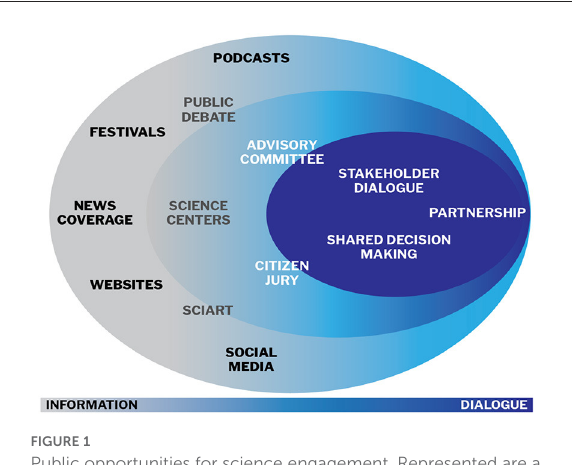
FIGURE1 Public opportunities for science engagement. Represented are a range of activities through which public audiences may participate in science, from largely information-gathering such as personal exploration on websites (represented on the left in gray) to mutually-informing dialogue that can even lead to collaboration (moving toward the right in dark blue). These activities are shaped by multiple dimensions of interactions between experts and public audiences—the goal of the interaction; the specific topic or focus; the attitudes, behaviors, and expectations of publics. These factors combine to create a spectrum of activities that frame the role of public audiences interacting with science as well as its societal